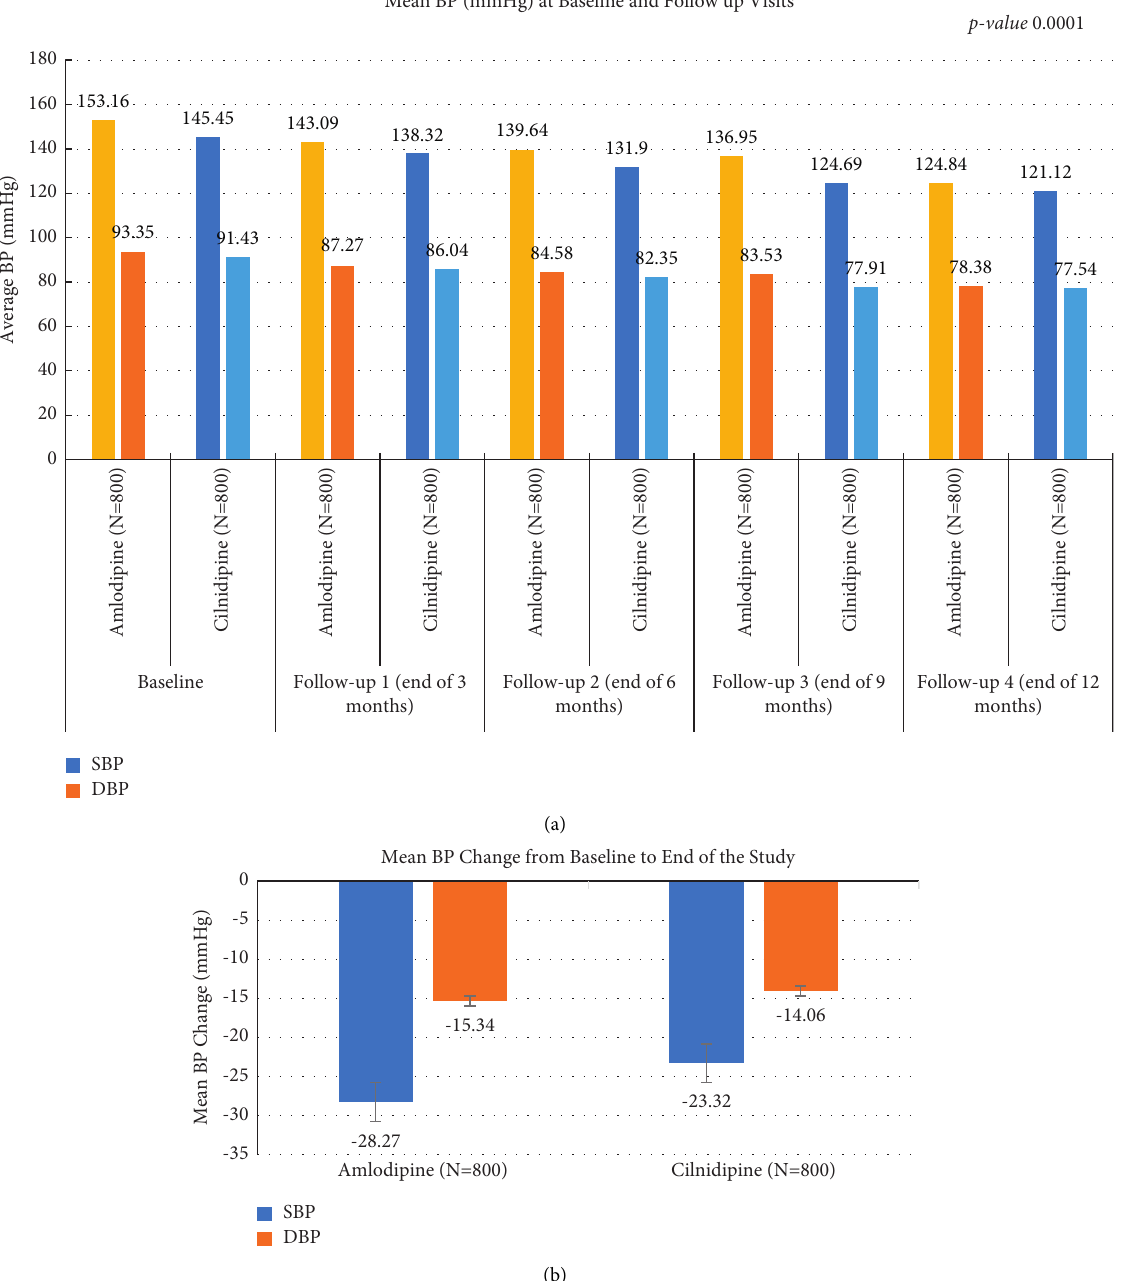
Figure 2: (a) Average BP (mmHg) from baseline to follow-up visits. (b) Mean change in BP from baseline to end of the